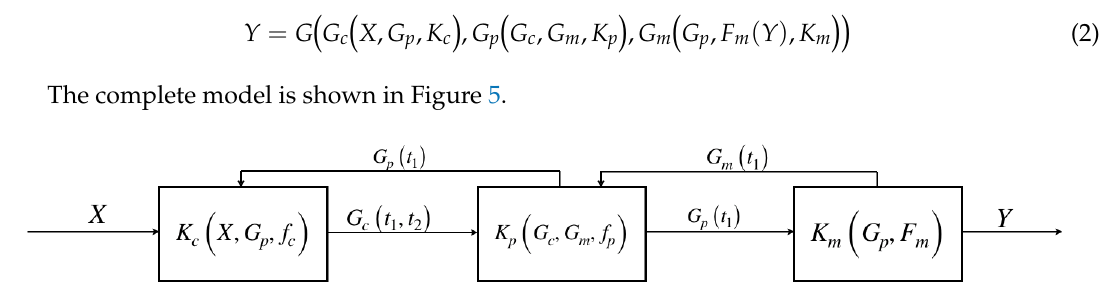
Figure 5. Complete Model of the Drilling Machine Dynamics.